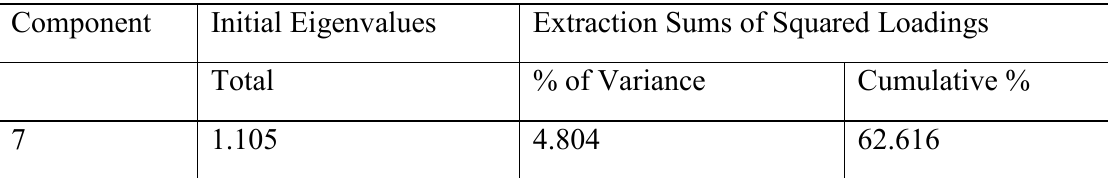
Table 1.35: Variance explained for Adaptive Resilience PC7 Component